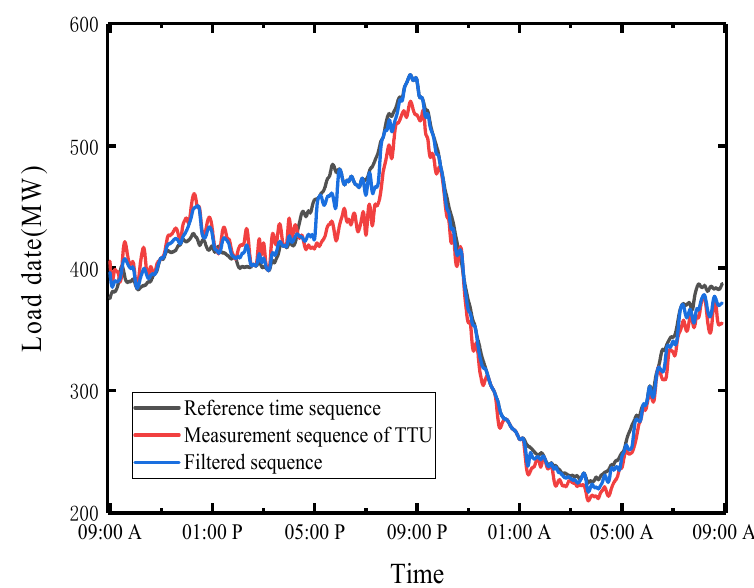
Figure 12. TTU measured active power curve based on reference time series filtering.